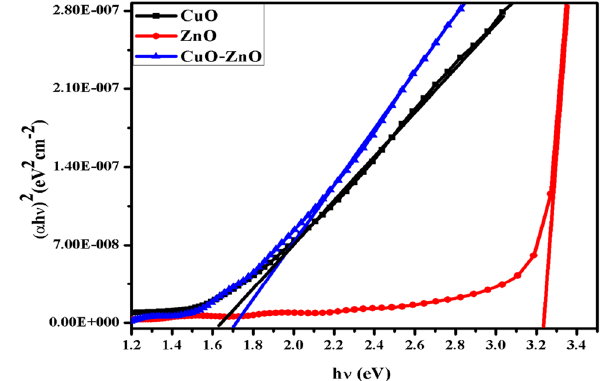
Fig. 5 Tauc plots for single and bilayer films at 500 °C